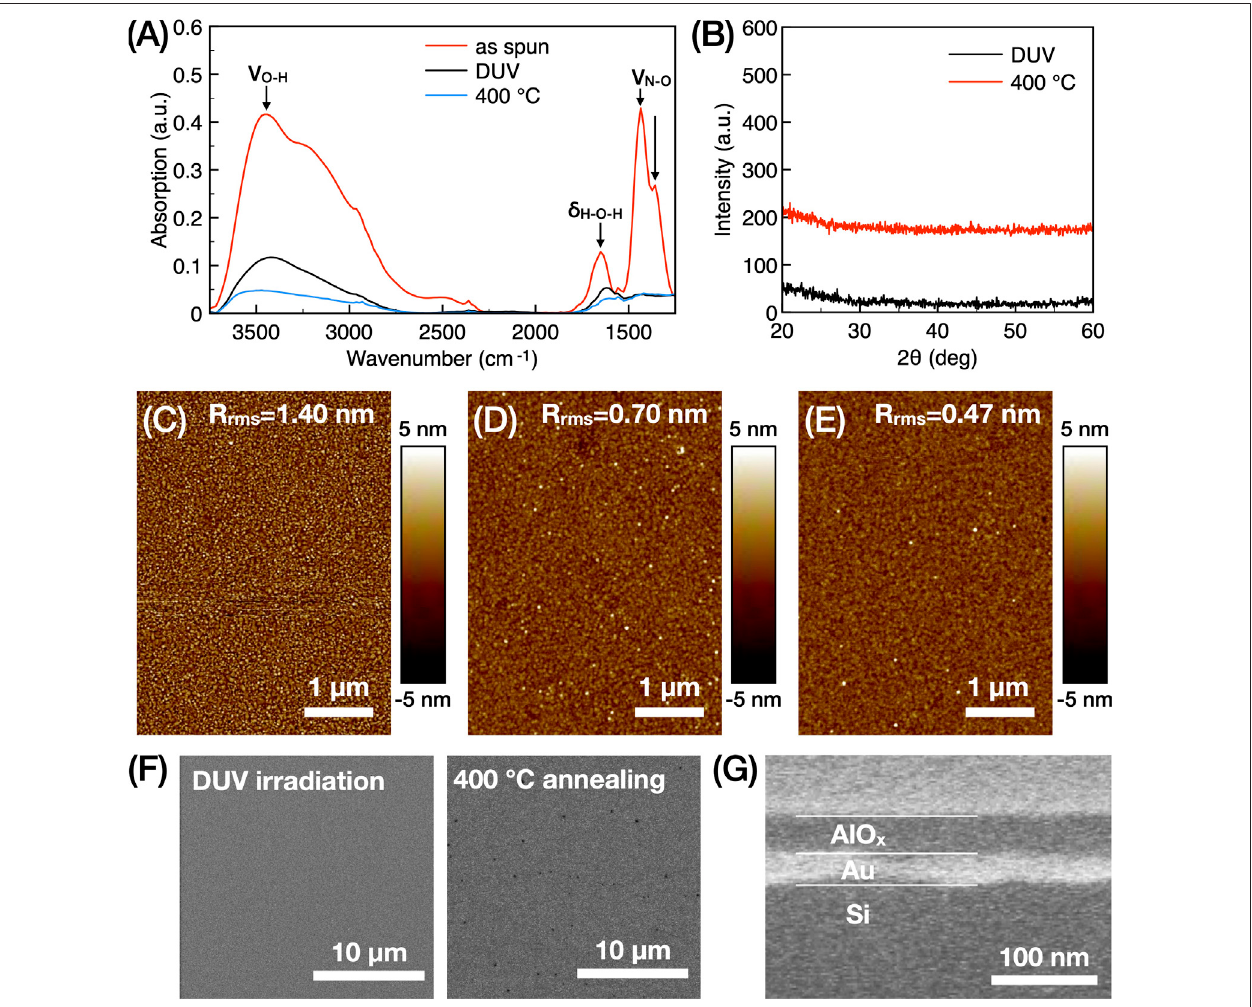
FIGURE 2 | (A) FTIR of the as-spun sample, DUV-treated, and high-temperature annealing samples. (B) In-plane XRD of DUV-treated and high-temperature annealing samples. (C – E) AFM images of the surface morphology of Au thin fi lm evaporated on glass, AlO x surface morphology of DUV-treated and high-temperature annealing samples, respectively. (F) Surface morphology of AlO x thin fi lm prepared by DUV irradiation and high temperature annealing, respectively. (G) Cross-section SEM image of AlO x thin fi lm.